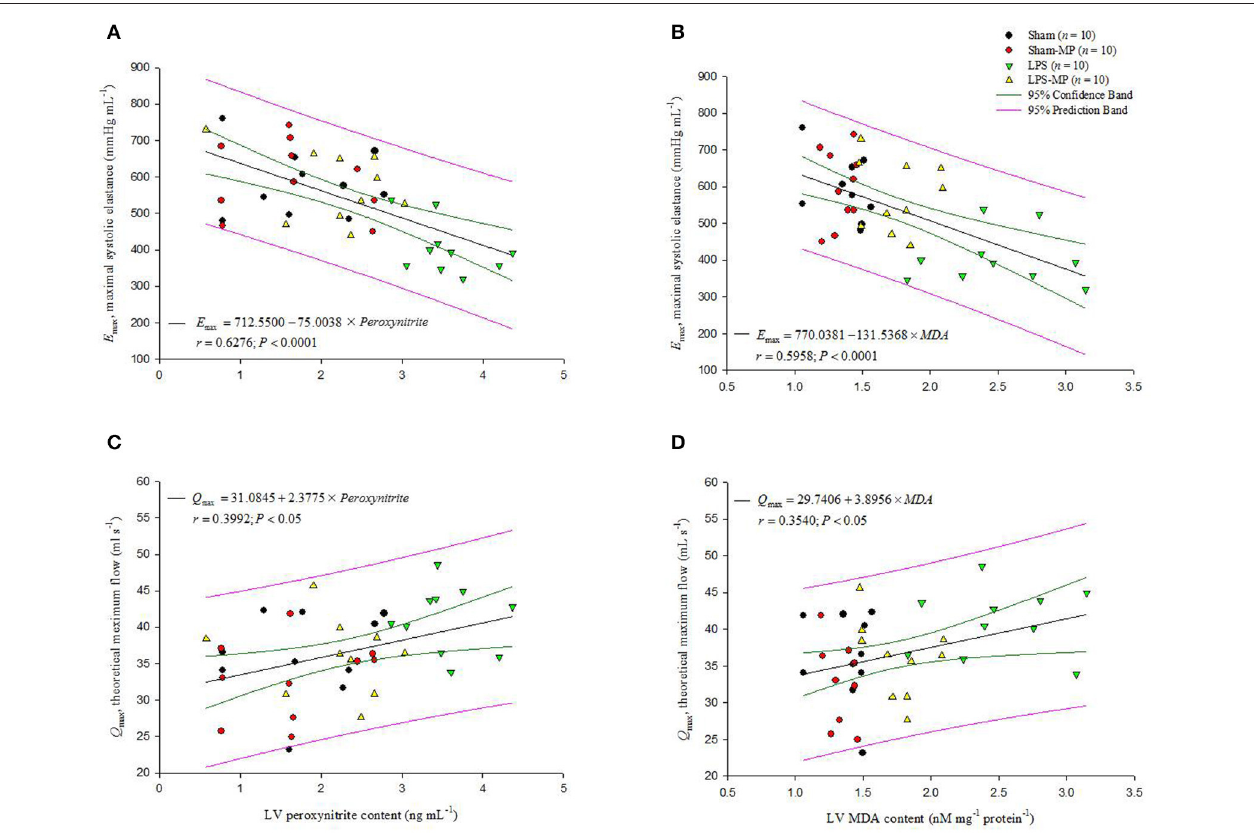
FIGURE 6 | Association of cardiodynamic parameters with the cardiac depressant substances. At the cardiac tissues, the LV E max is inversely related with either LV peroxynitrite level (A) or LV MDA content (B) . By contrast, the LV Q max increased in response to an increase in LV peroxynitrite level (C) or to the increased LV MDA content (D) . E max , maximal systolic elastance; Q max , theoretical maximum flow; MDA, malondialdehyde ( n = 10